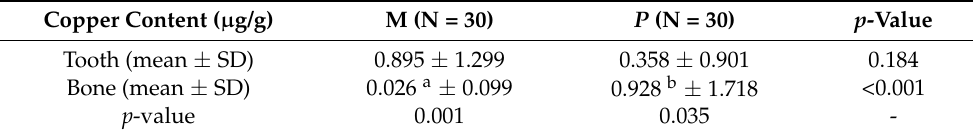
Table 21. Copper content in tested samples taken from patients differing in place of residence.